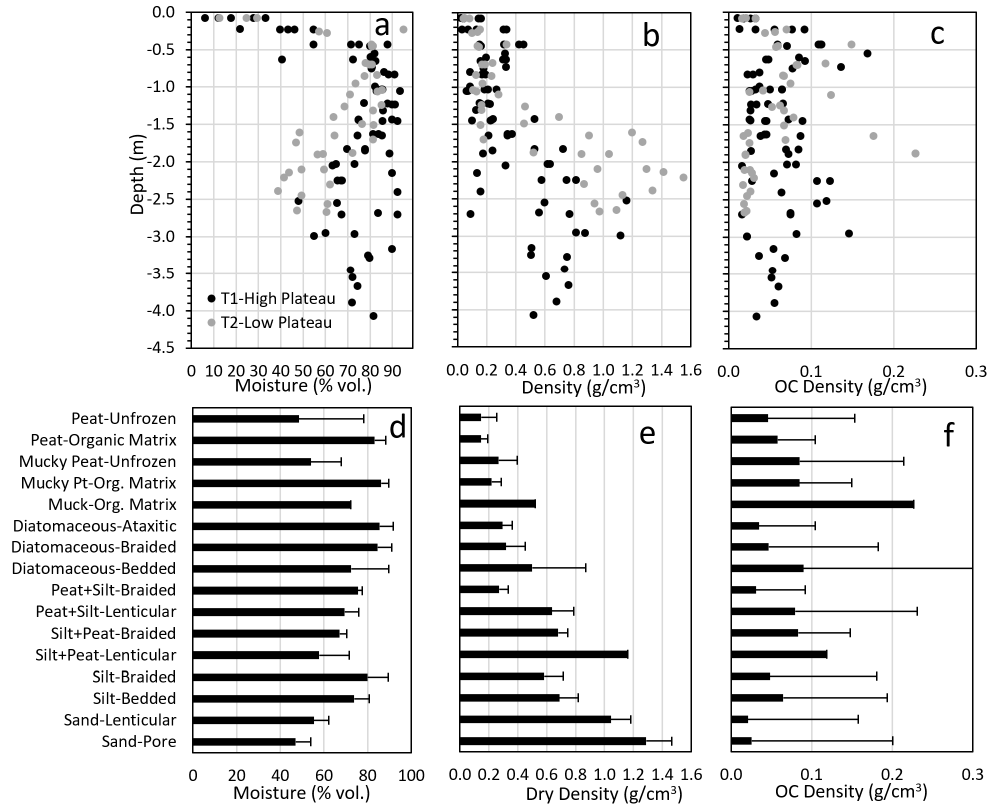
Figure 12. Soil volumetric moisture content ( a ), dry density ( b ), and organic carbon density ( c ) in relation to depth on the high (T1) and low (T2) permafrost plateaus at Gosling Lake. Mean (±SD) moisture ( d ), dry density ( e ), and OC density ( f ) by soil texture cryostructure groups are provided in the bottom row.